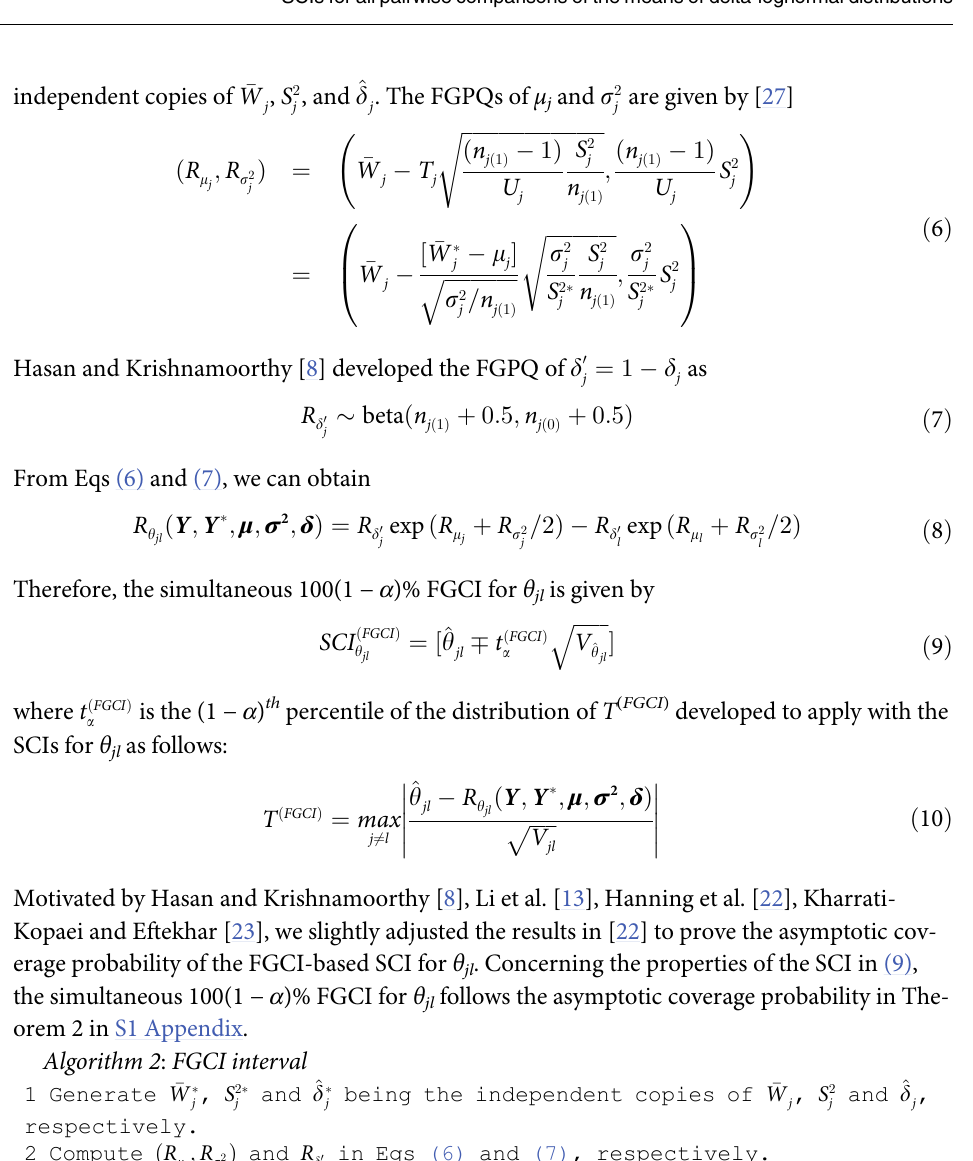
Algorithm 2 : FGCI